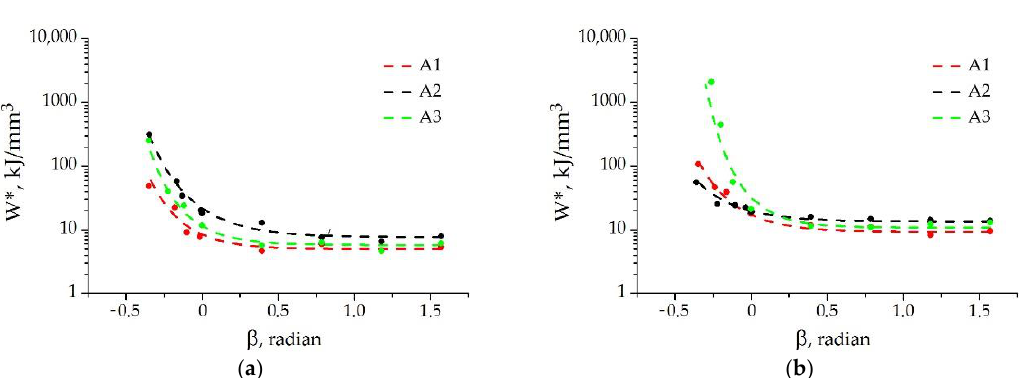
Figure 6. The fracture loci W *( β ) for the adhesive joints at test temperatures of +23 °C ( a ) and −50 °C ( b ): dots—experimental data; dashed lines—approximation by Equation (9).